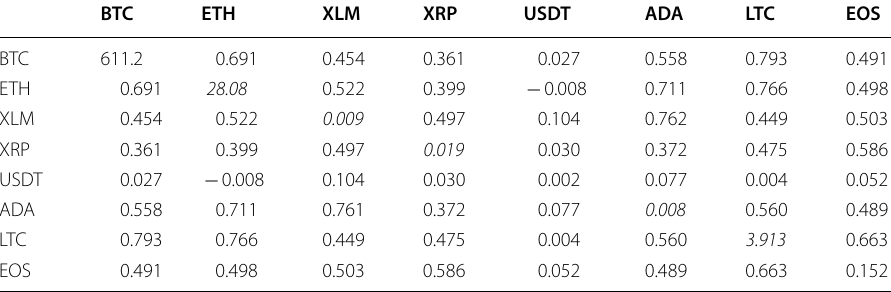
Table 8 The unconditional volatility